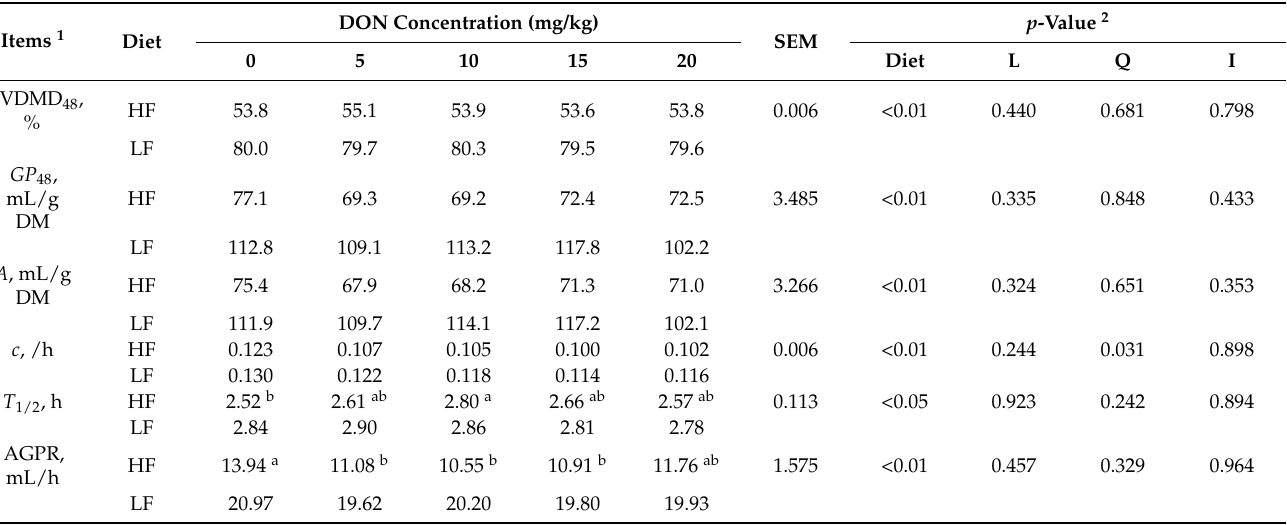
Table 4. Effect of DON concentration (mg/kg) in culture fluids on kinetic gas production during 48 h incubation.